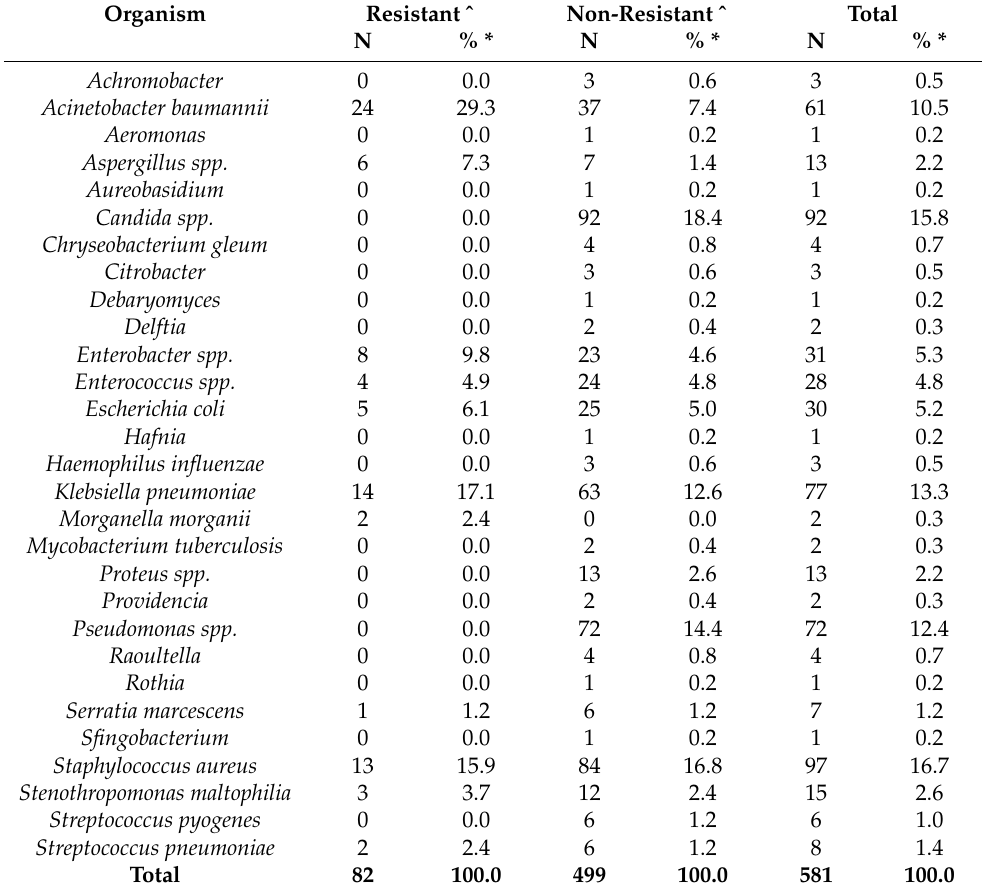
Table 2. Distribution of microbiological isolates in respiratory specimens from patients with HARI.